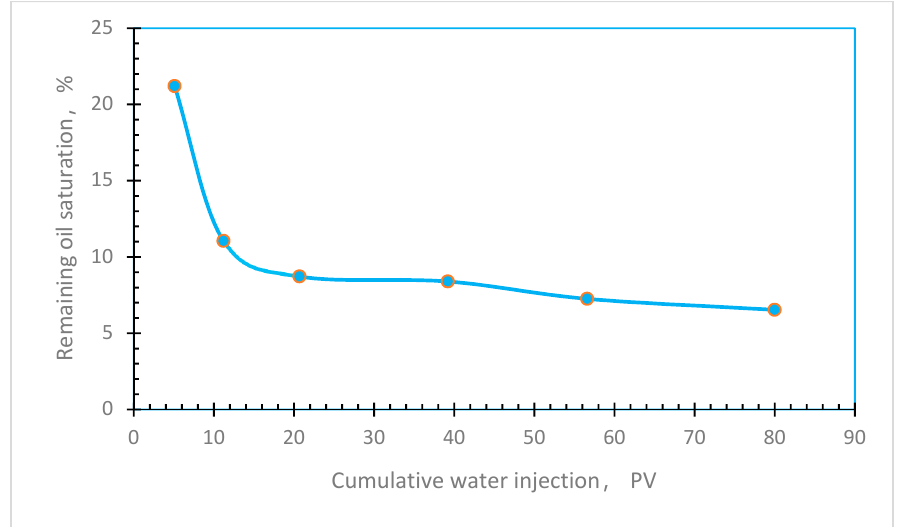
Figure 7. Relationship between cumulative injected PV number and displacement remaining oil saturation.